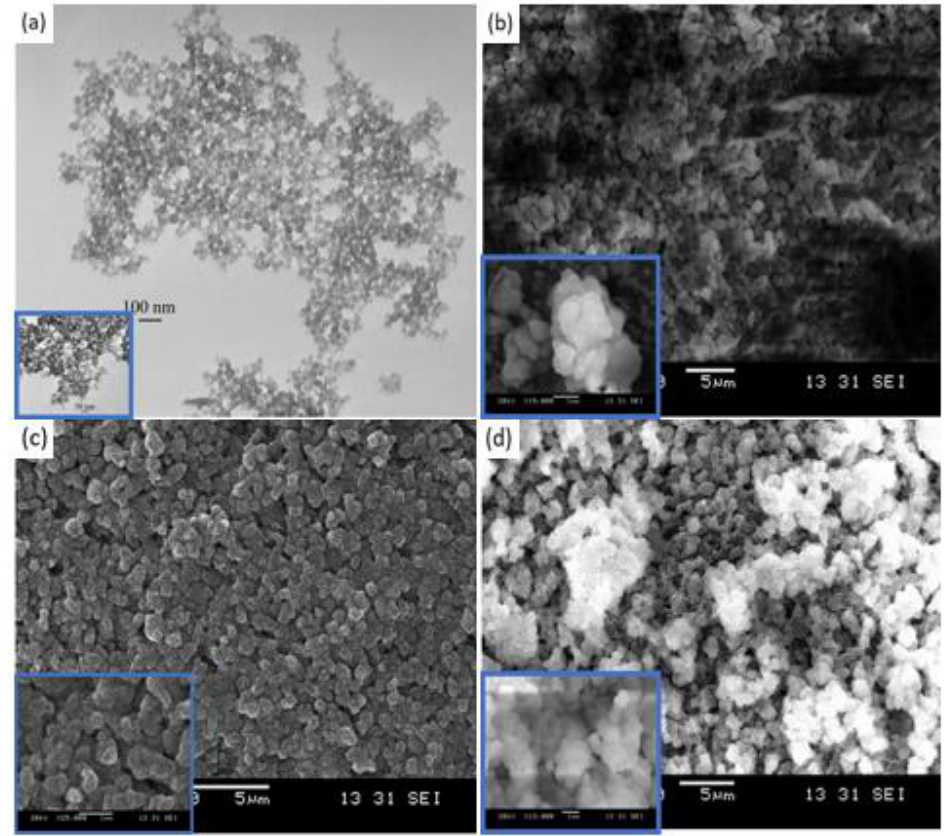
Figure 7. ( a ) Scanning electron microscopy (SEM) of the PS nanoparticles, where the diameter of the particles was around 50 nm; ( b ) SEM of the PSTFSILi nanoparticles, where the diameter of the particles was around 500 nm; ( c ) SEM of the PSPhSILi nanoparticles, where the diameter of the particles was around 500 nm; ( d ) SEM of the PSDTTOLi nanoparticles, where the diameter of the particles was around 350 nm [21,25].